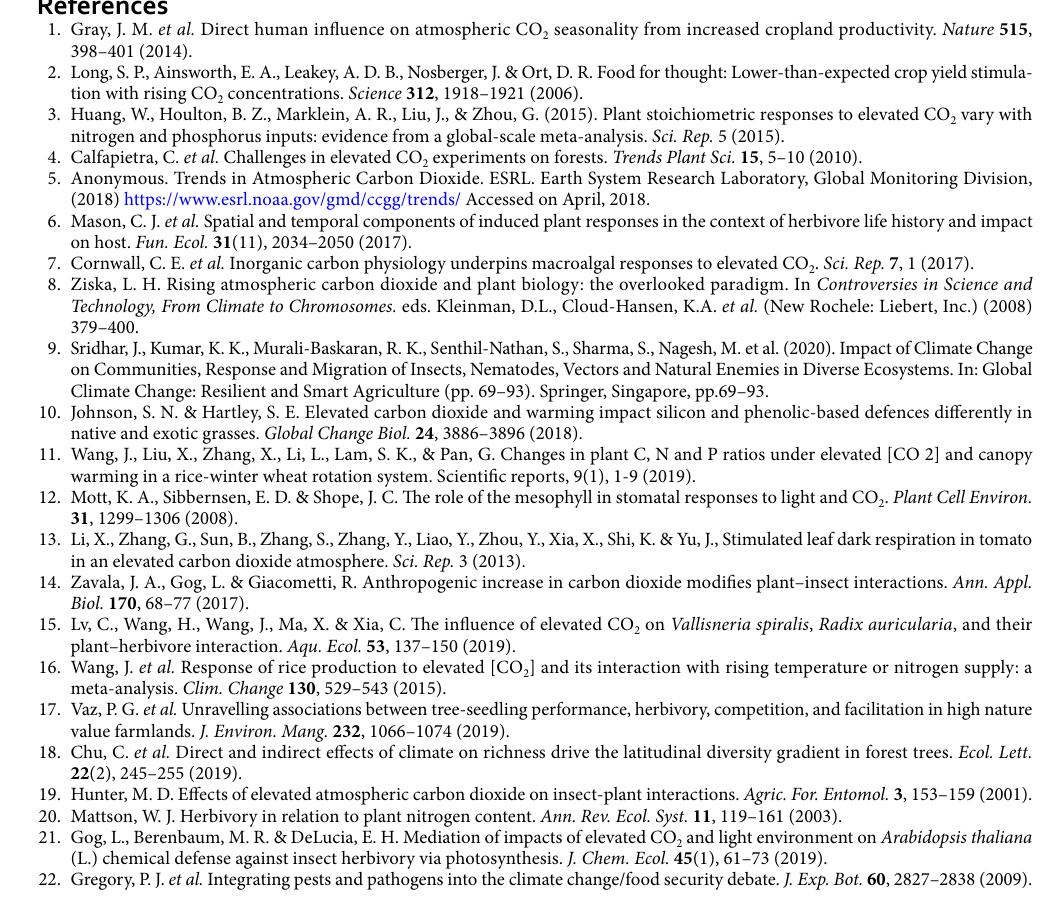
The datasets generated during and/or analyzed during the current study are not publicly available due to fund- ing agency agreement and intellectual properties but are available from the corresponding author on reasonable request with permission of funding